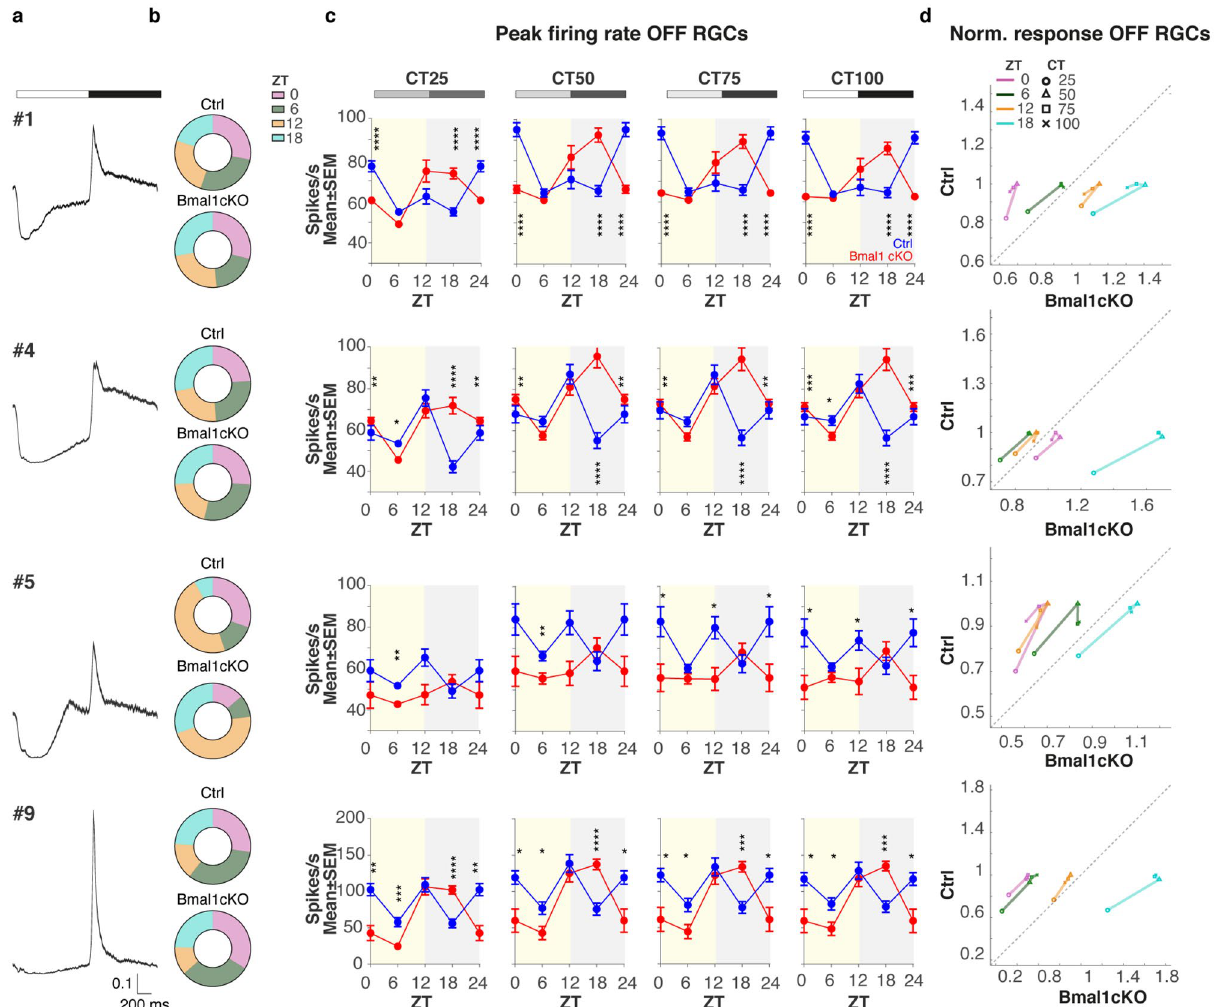
Figure 6. Bmal1 deletion affects OFF RGCs maximum firing rate in response to light in mesopic conditions. (a) Averaged normalized PSTH (mean ± SEM) of all RGCs belonging to the most abundant OFF clusters (both genotypes, all ZTs at CT100) #1, #4, #5, and #9 in response to full-field white-black alternating flashes (stimulus indicated above). (b) The proportion of all recorded RGCs per ZTs (Top, Ctrl, and bottom, Bmal1 cKO). (c) Analysis of the maximum firing rate in response to alternating bright and dark flashes performed on selected OFF RGCs clusters (different rows) at four different ZTs (0, 6, 12, 18) and different contrasts (CTs, different columns). Data are shown as mean ± SEM between cells belonging to a specific cluster, separately for Ctrl (blue) and Bmal1 cKO (red). Asterisks mark a significant difference between groups. (Kolmogorov–Smirnov test; *P < 0.05, **P < 0.01, ***P < 0.001, ****P < 0.0001). (d) Scatter plots of RGCs peak amplitudes normalized to the maximal response of the control throughout the day in Ctrl (y-axes) vs. Bmal1 cKO (x-axes) conditions. Different colors indicate results obtained at diverse ZTs, and the symbols denote contrast conditions. Dashed line: unity